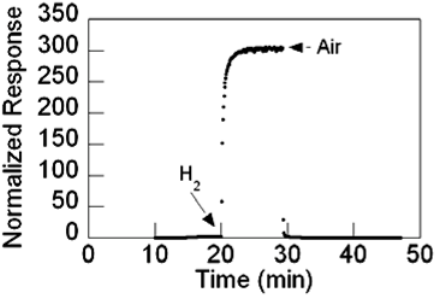
sensor to 0.5% H 2